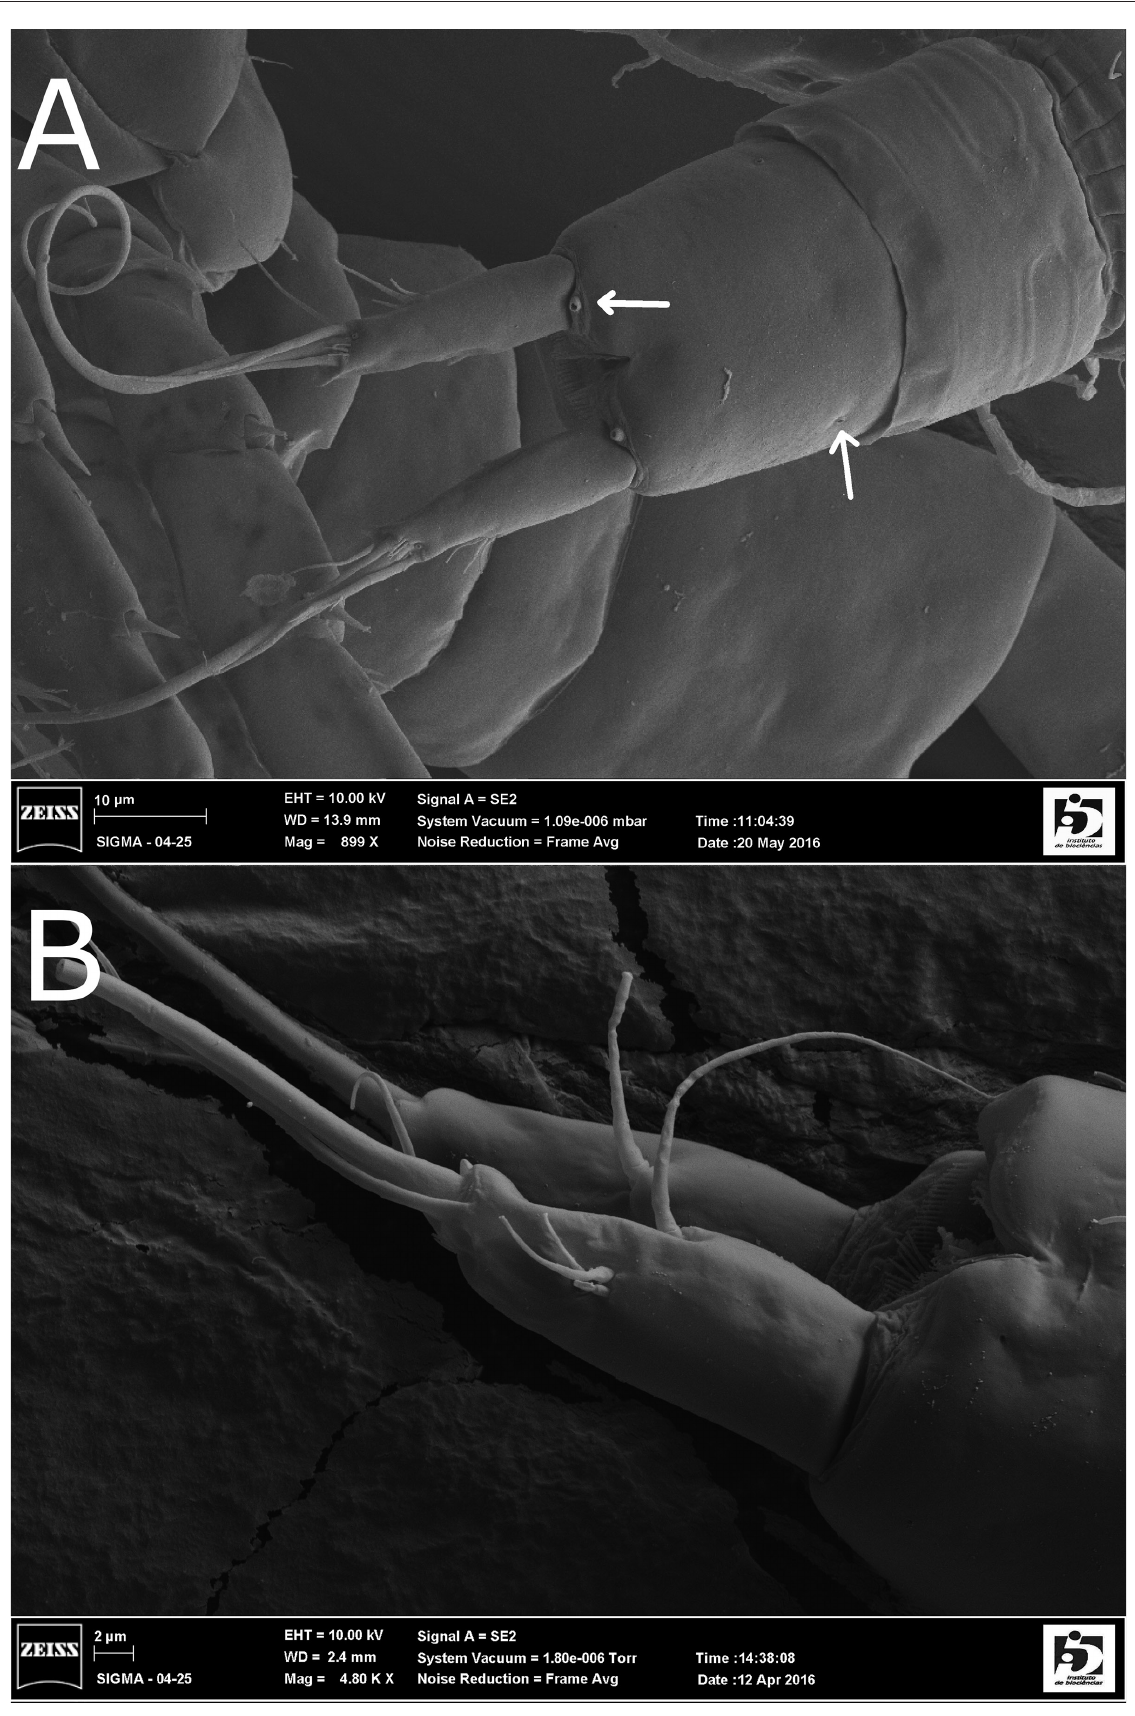
Figure 8. Eirinicaris antonioi sp. n. Female: A last urosomite, telson and furca, ventral view, proximal and distal pores arrowed; B telson and furca, lateral view. Scale bars A = 2µm; B =